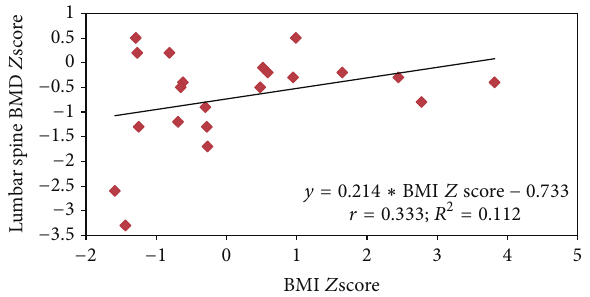
Figure2:RelationshipbetweenlumbarspineBMD Z scoreandBMI Z